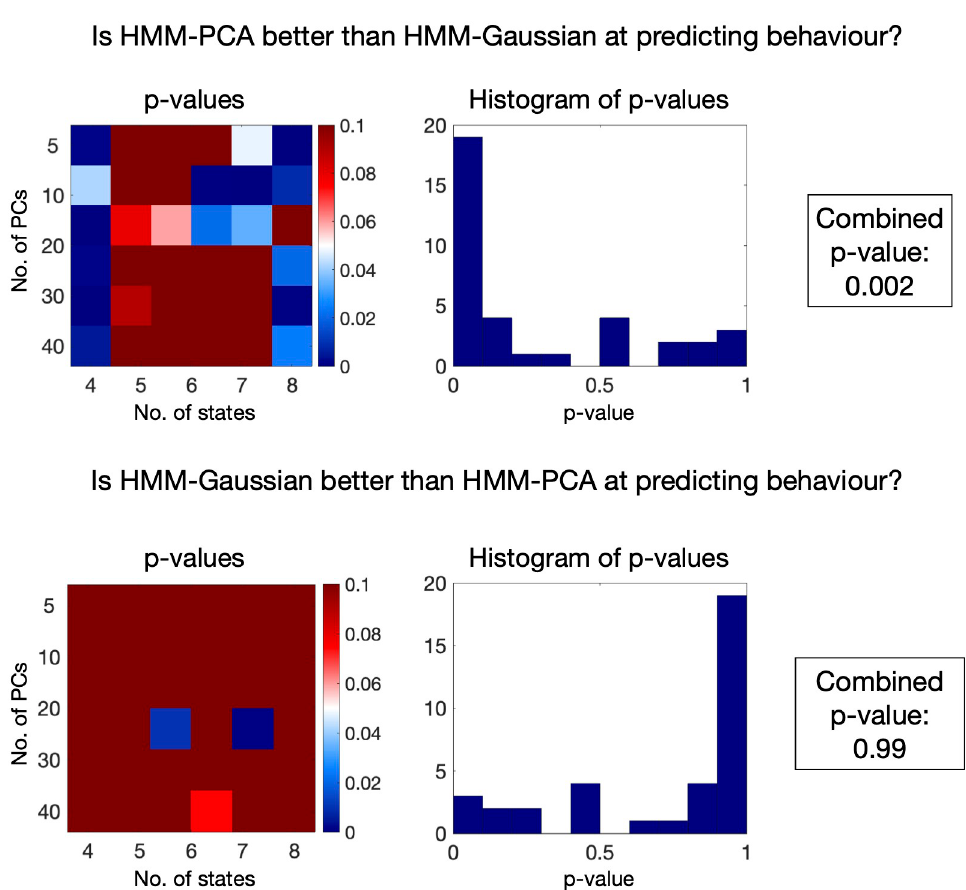
Fig 6. Behavioural predictions of HMM-Gaussian and HMM-PCA across a range of parameters. Similarly to Fig 5, the fractional occupancy was used to predict a set of behavioural traits. Permutation testing was used to test whether, for each combination of parameters, the HMM-PCA solutions were better than the HMM-Gaussian solutions (top), and whether the HMM-Gaussian solutions were better than the HMM-PCA solutions (bottom). On the left side: the corresponding p-values, where colder colours mean statistically significant; at the center: histograms of p-values across all combinations of hyperparameters; on the right side: the result of combining all the tests into one single, aggregated test, using the non-parametric combination algorithm –as used in